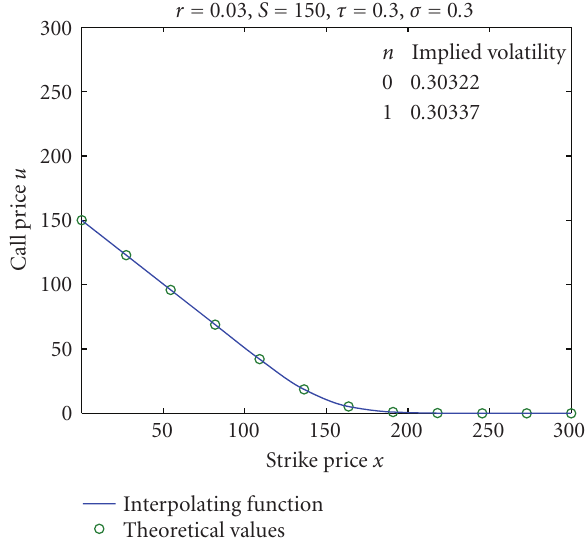
Figure 4.2 . Theoretical call prices and implied volatility using